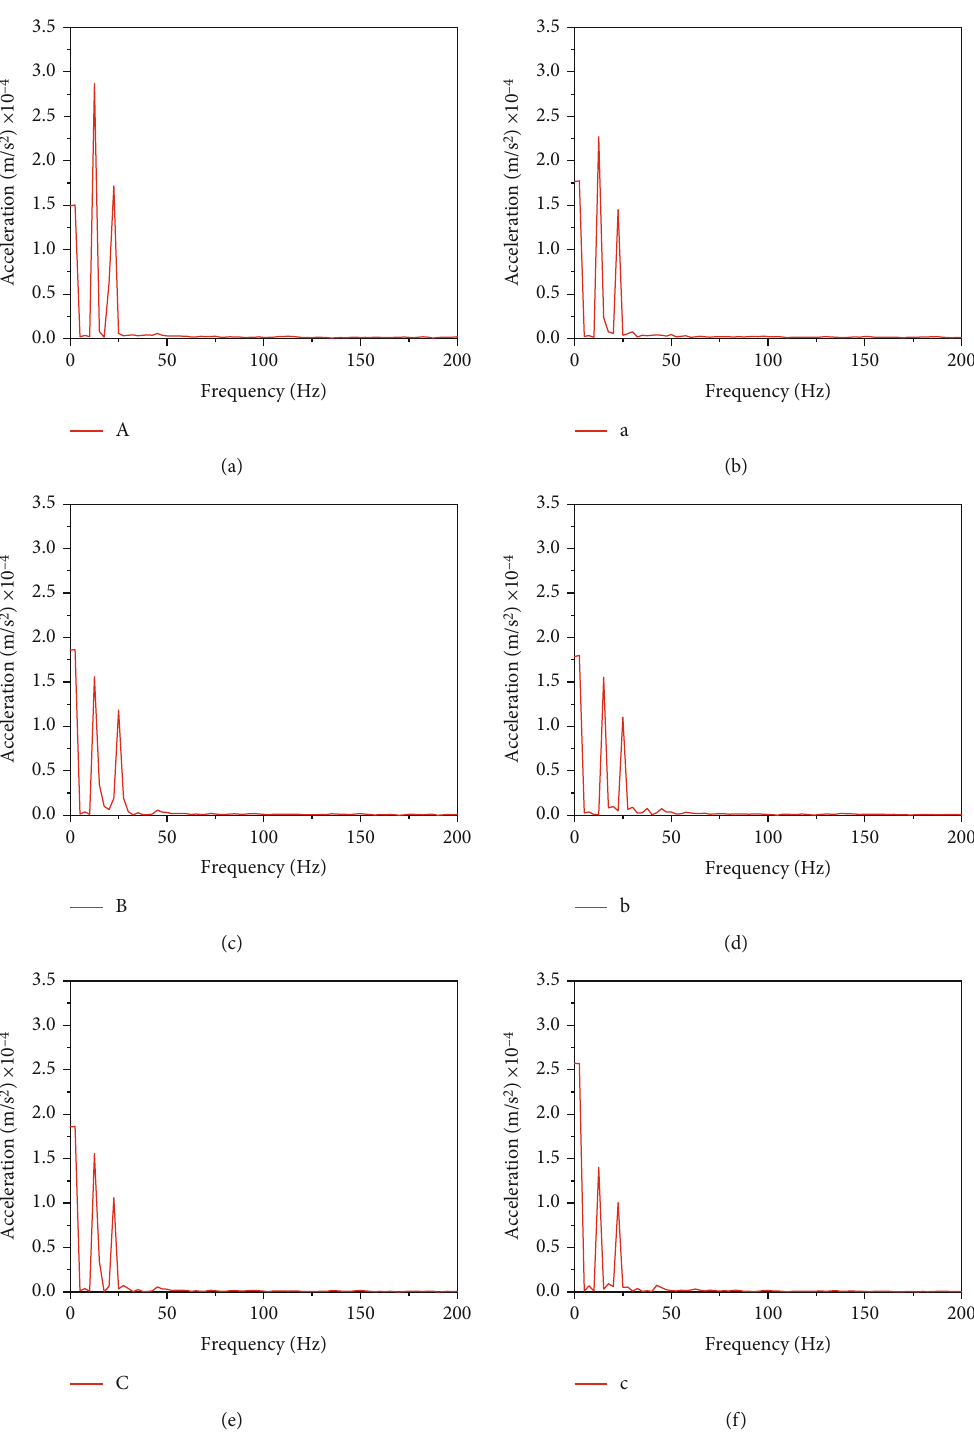
Figure 6: Frequency domains for the six faces of the dried lignite coal